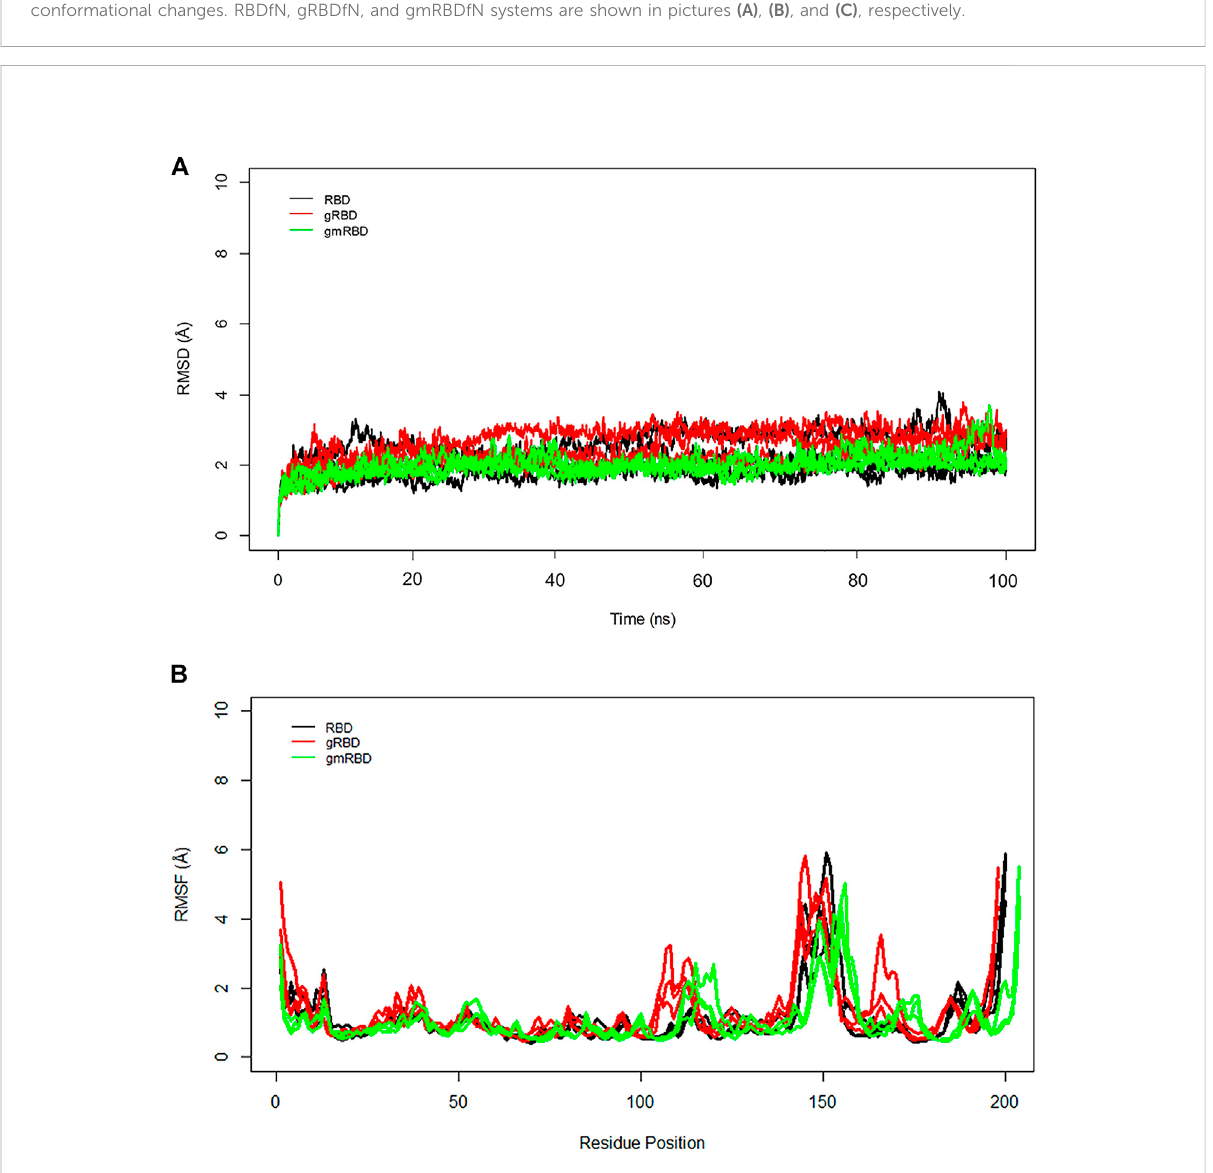
FIGURE 7 (A) RMSD of all systems is calculated for RBD over 100 ns MD simulations. The structural distance of CA atoms calculated for all replicates of RBD, gRBD, and gmRBD systems are shown in black, red, and green, respectively. (B) RMSF of all systems is calculated for RBD over 100 ns MD simulations.FluctuationsofCAatomscalculatedforallreplicatesofRBD,gRBD,andgmRBDsystemsareshowninblack,red,andgreen,respectively.